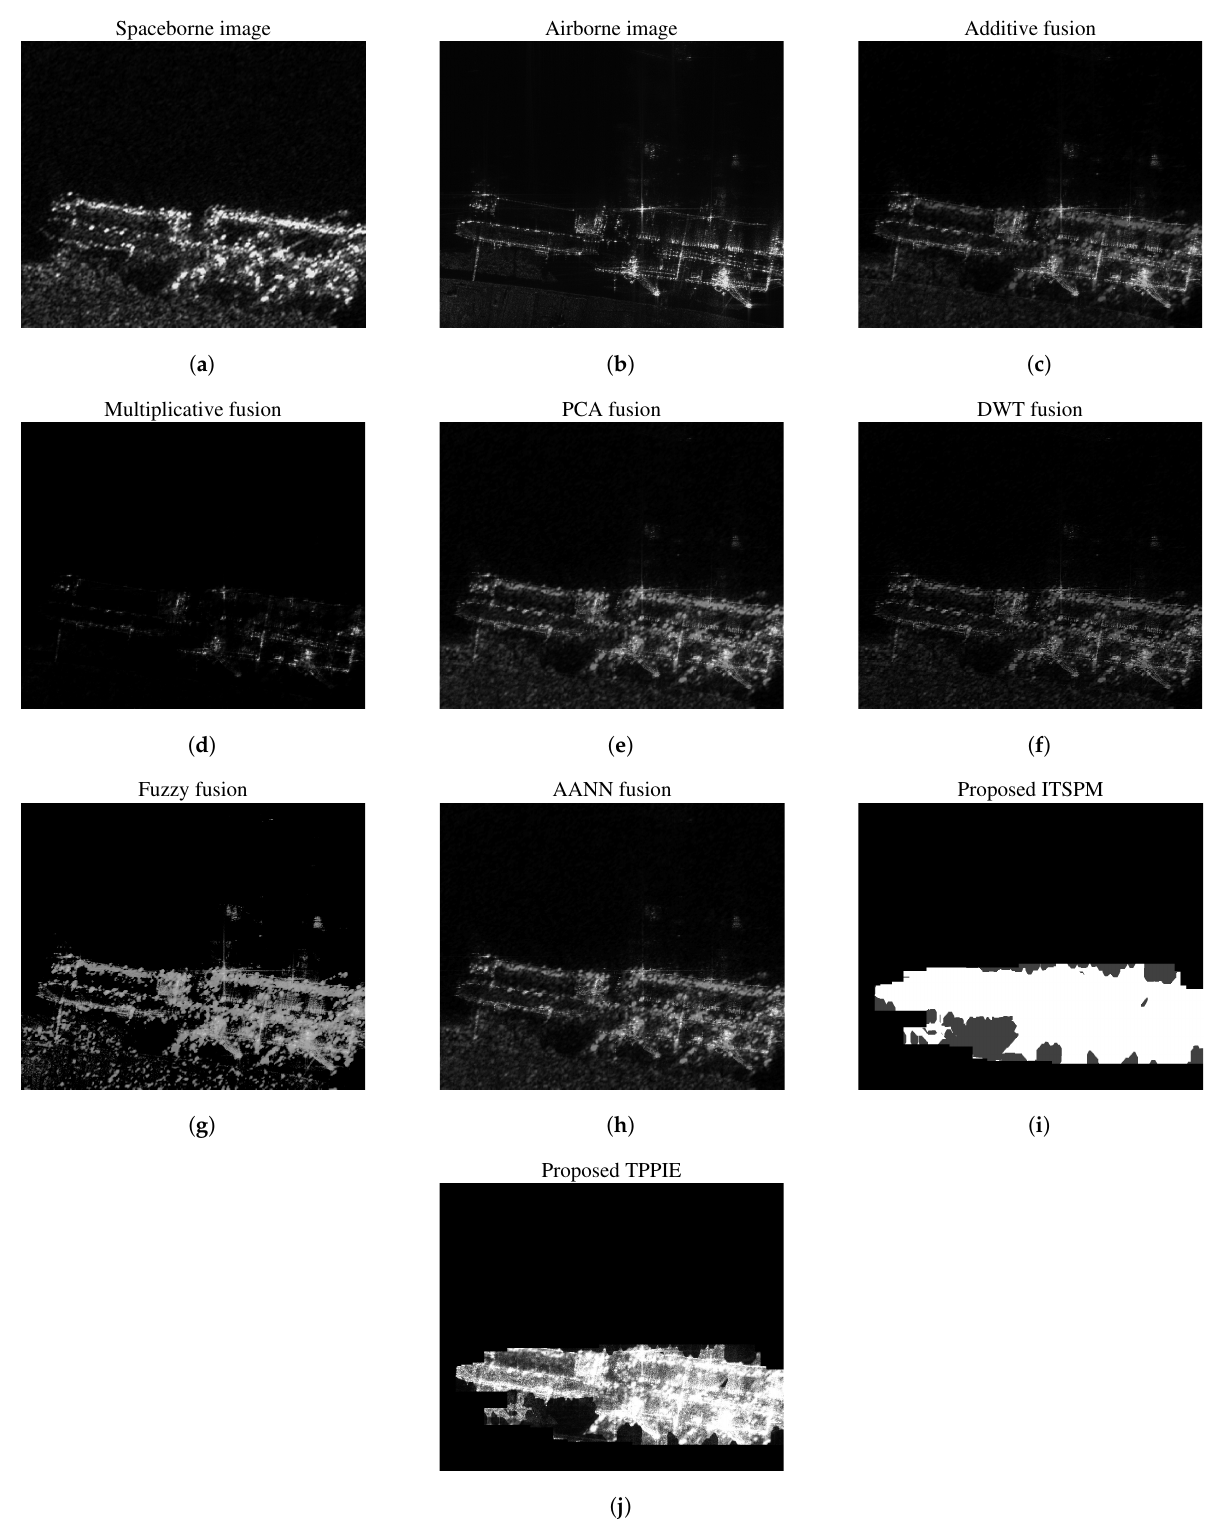
Figure 8. Experimental results for scene 3: ( a ) Spaceborne image; ( b ) airborne image; ( c ) additive fusion [10]; ( d ) multiplica- tive fusion [10]; ( e ) PCA fusion [12]; ( f ) DWT fusion [13]; ( g ) fuzzy fusion [16]; ( h ) AANN fusion [18]; ( i ) proposed ITSPM fusion; and ( j ) proposed TPPIE fusion. The proposed methods can achieve better fused images with enhanced target regions and suppressed background regions, compared to the other image fusion